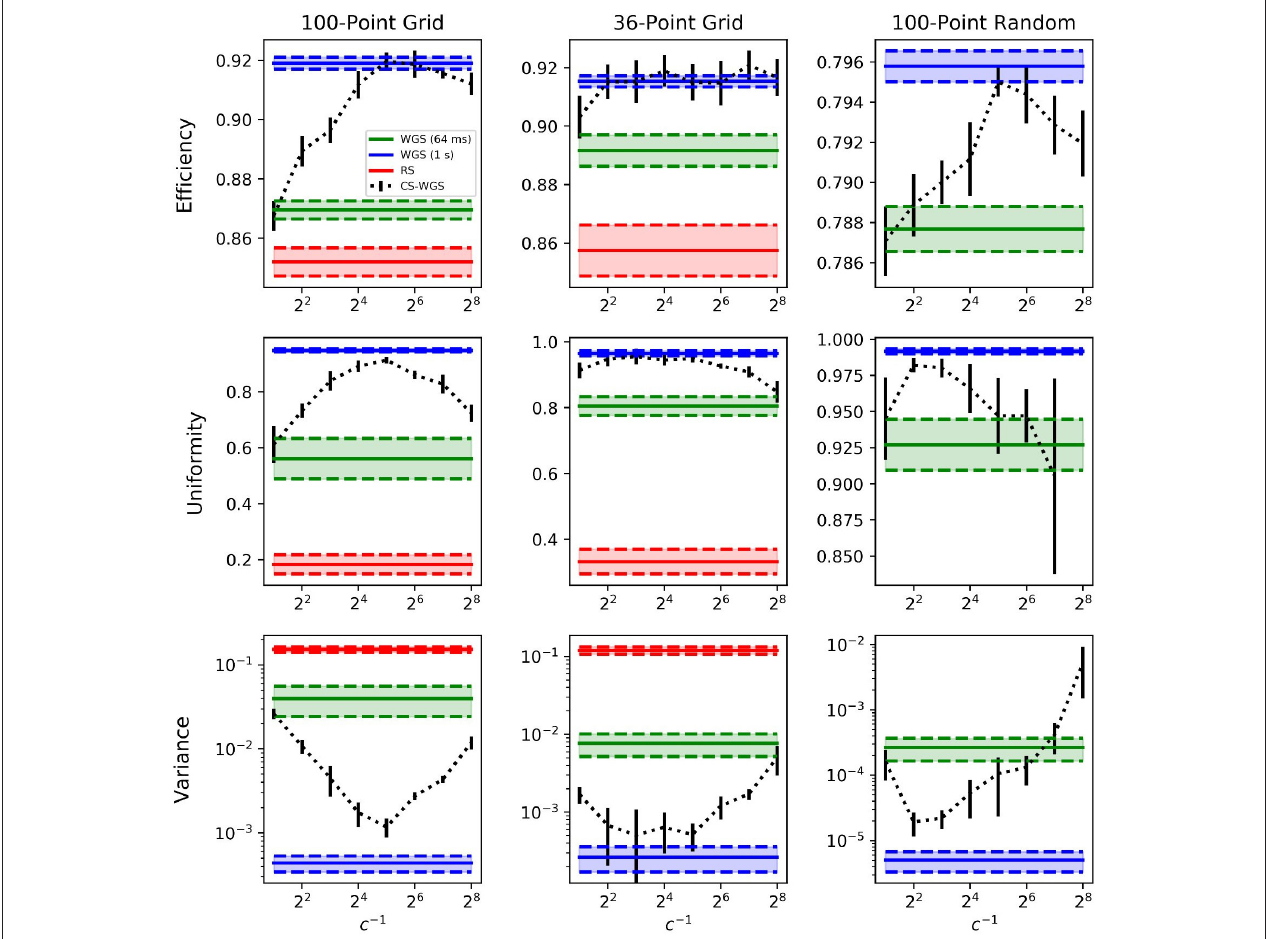
FIGURE 3 | Performance comparison of the algorithms when computing in real time at 15 Hz in selected scenarios. The legend is valid for all graphs. RS results for the 100 points random distribution has been omitted as out of a reasonable graph scale at e = 0.554 ± 0.004, u = 0.0245 ± 0.004 and v = 0.44 ± 0.22. Similarly, the CS-WGS uniformity for the same pattern at 2 − 8 compression was omitted, scoring u = 0.46 ± 0.17. RS computation times were approximately 25 ms for 100 spots patterns, and 12 ms for 36 spots patterns. Error bars report standard